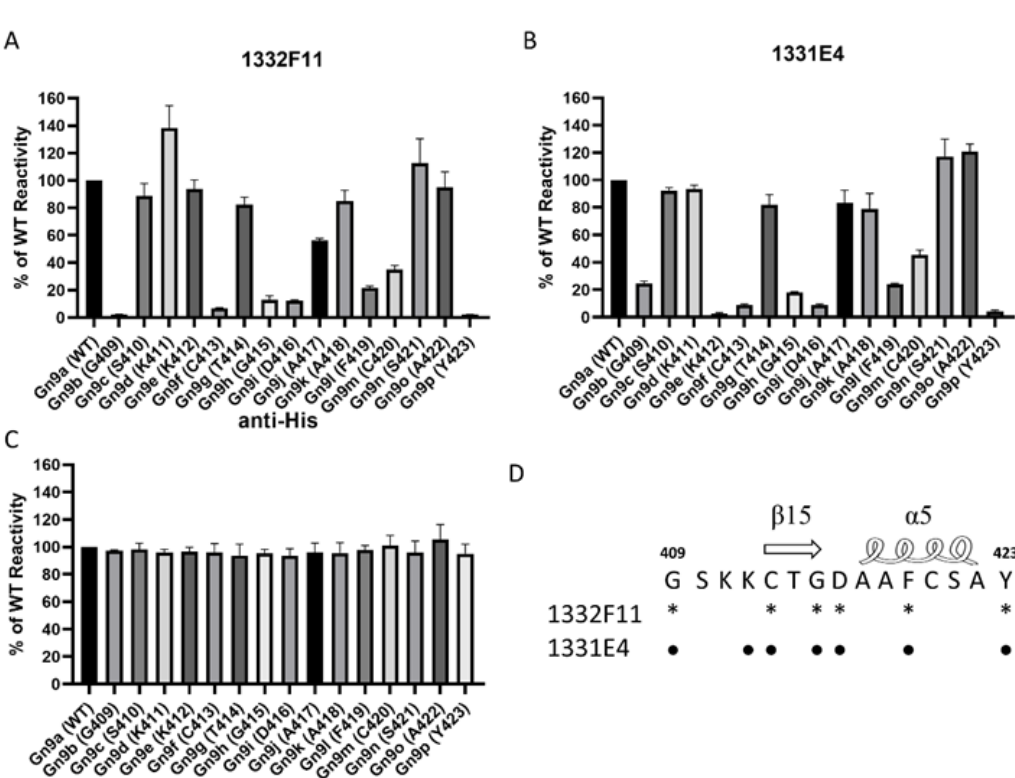
Figure 5. Mapping of NAb epitopes based on the polypeptide 409 GSKKCTGDAAFCSAY 423 in Gn9a using alanine-scanning mutagenesis. ( A , B ) These purified segments, coated on a 96-well plate (0.2 µ g / well), were incubated with 1332F11 (0.5 µ g / mL) and 1331E4 (0.01 µ g / mL). Antibody reactivity against each mutant segment was calculated relative to wild-type (WT) Gn9a reactivity by normalizing to the OD 450 –OD 630 from wild-type Gn9a. ( C ) The anti-His antibody (1:5000 initial dilution) was used as positive control. Data are presented as the means ± standard deviations (error bars) from three independent trials. ( D ) The critical residues for 1332F11 are labeled with asterisks, and the critical residues for 1331E4 are labeled with black dots.